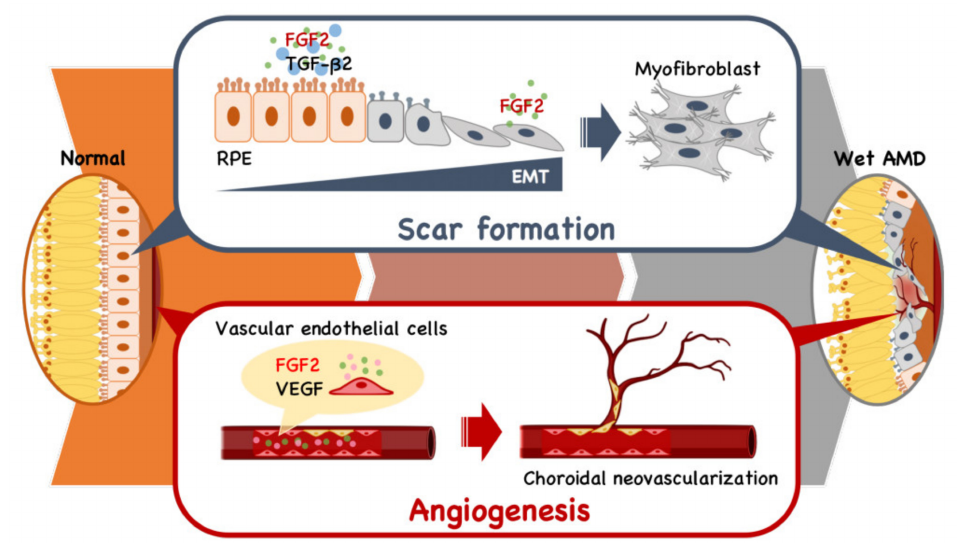
Figure 2. Schematic model of the dual role of FGF2 in angiogenesis and fibrotic scar formation in the retina. The presence of TGFb2 stimulates retinal pigment endothelial (RPE) cells to undergo epithelial- mesenchymal transformation (EMT) to fibroblasts, leading to scar formation. In parallel, FGF2